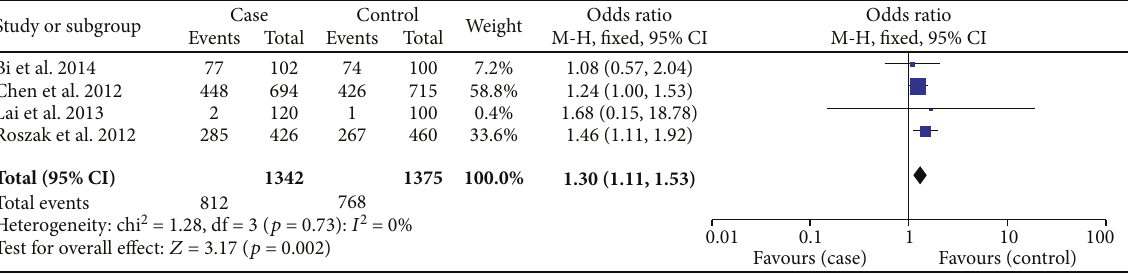
Figure 4: Forest plots of the association between TLR9 rs187084 polymorphism and cervical cancer risk in the dominant genetic model. Table 4: Meta-analysis results of rs187084 based on fi ve genetic